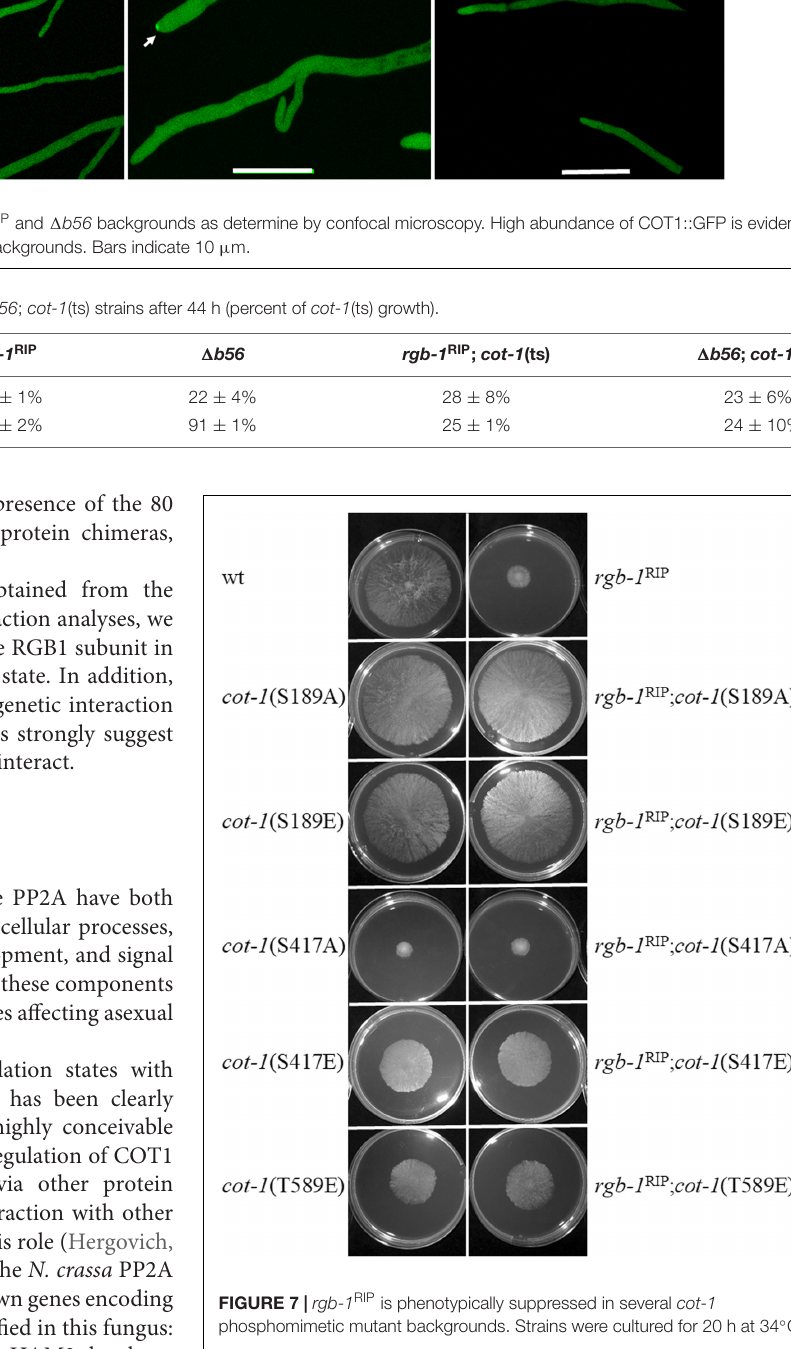
Previously, Yatzkan and Yarden (1999) demonstrated that inactivation of rgb-1 by repeat induced point mutations (RIP) affected hyphal growth and conidiation. The rgb-1 RIP